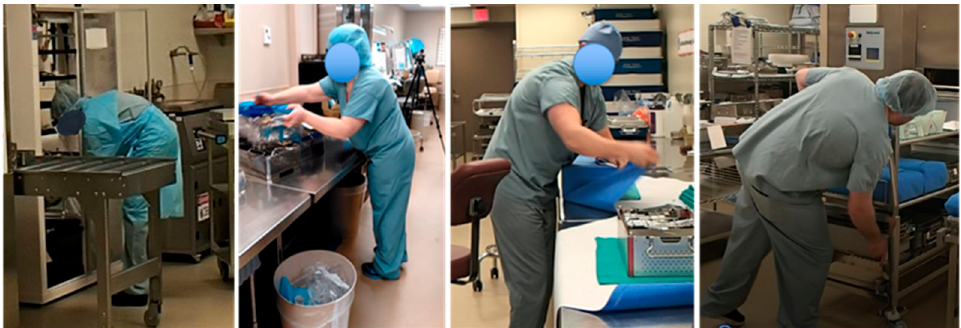
Figure 18. Employees adopting awkward positions before the KE.